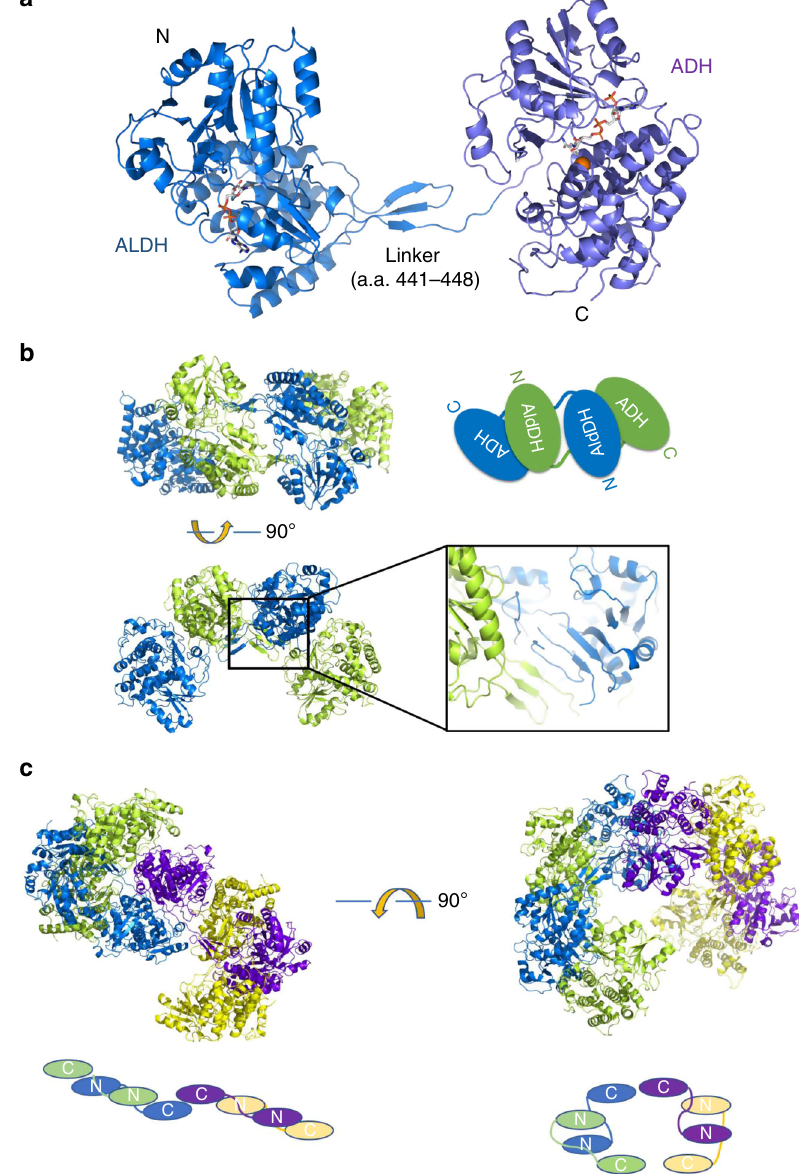
Fig. 3 Hierarchical formation of AdhE spirosome from a monomer. a A full-length AdhE monomer is shown as a ribbon model. The N-terminal ALDH domain (royal blue) and C-terminal ADH domain (light purple) are linked by a short β -sheet composed of one β -strand from the linker and two β -strands from the ALDH domain. NAD + and Fe 2 + were modeled from other alcohol dehydrogenase structures (PDB IDs: 3MY7, 3ZDR). b AdhE forms a dimer by interacting in a head-to-head arm-crossing fashion. The short β -sheet in the linker forms a continual β -sheet with the β -sheet from the ALDH domain. c ADH domains from the AdhE dimer interact in a tail-to-tail manner and a total of four AdhE molecules make one helical